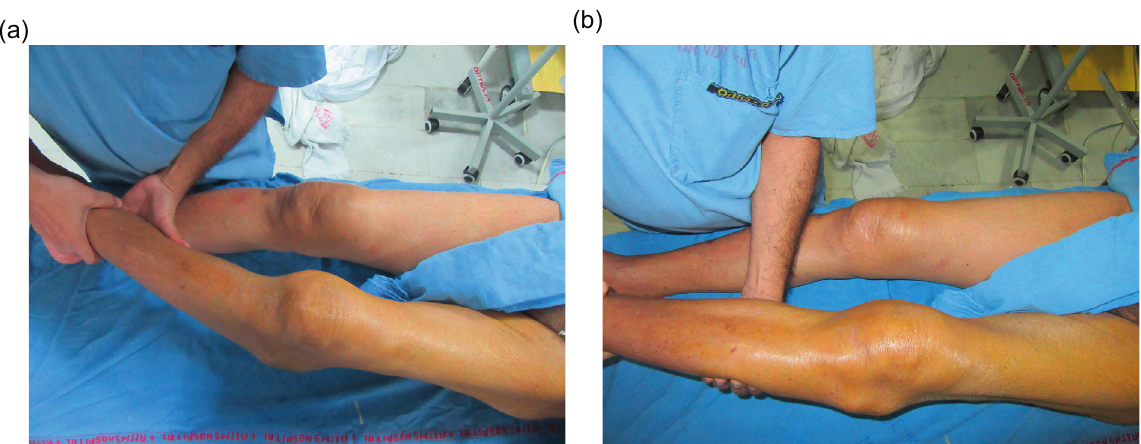
Figure 3. (a) Examination of the ligaments in maximal extension revealed 10 mm of opening of the lateral joint line on varus stress test with a soft end. (b) Examination of the ligaments in maximal extension revealed improvement of the alignment to normal with valgus stress.